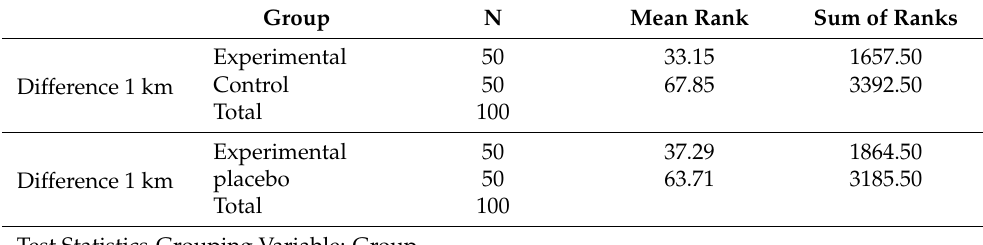
Table 3. Post-hoc test 1 km.